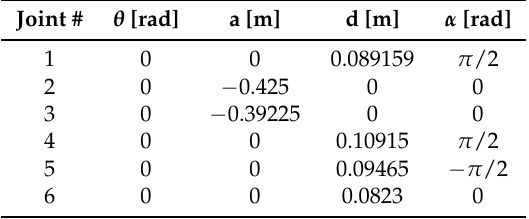
Table 1. Denavit-Hartenberg parameters of the UR5 robot.